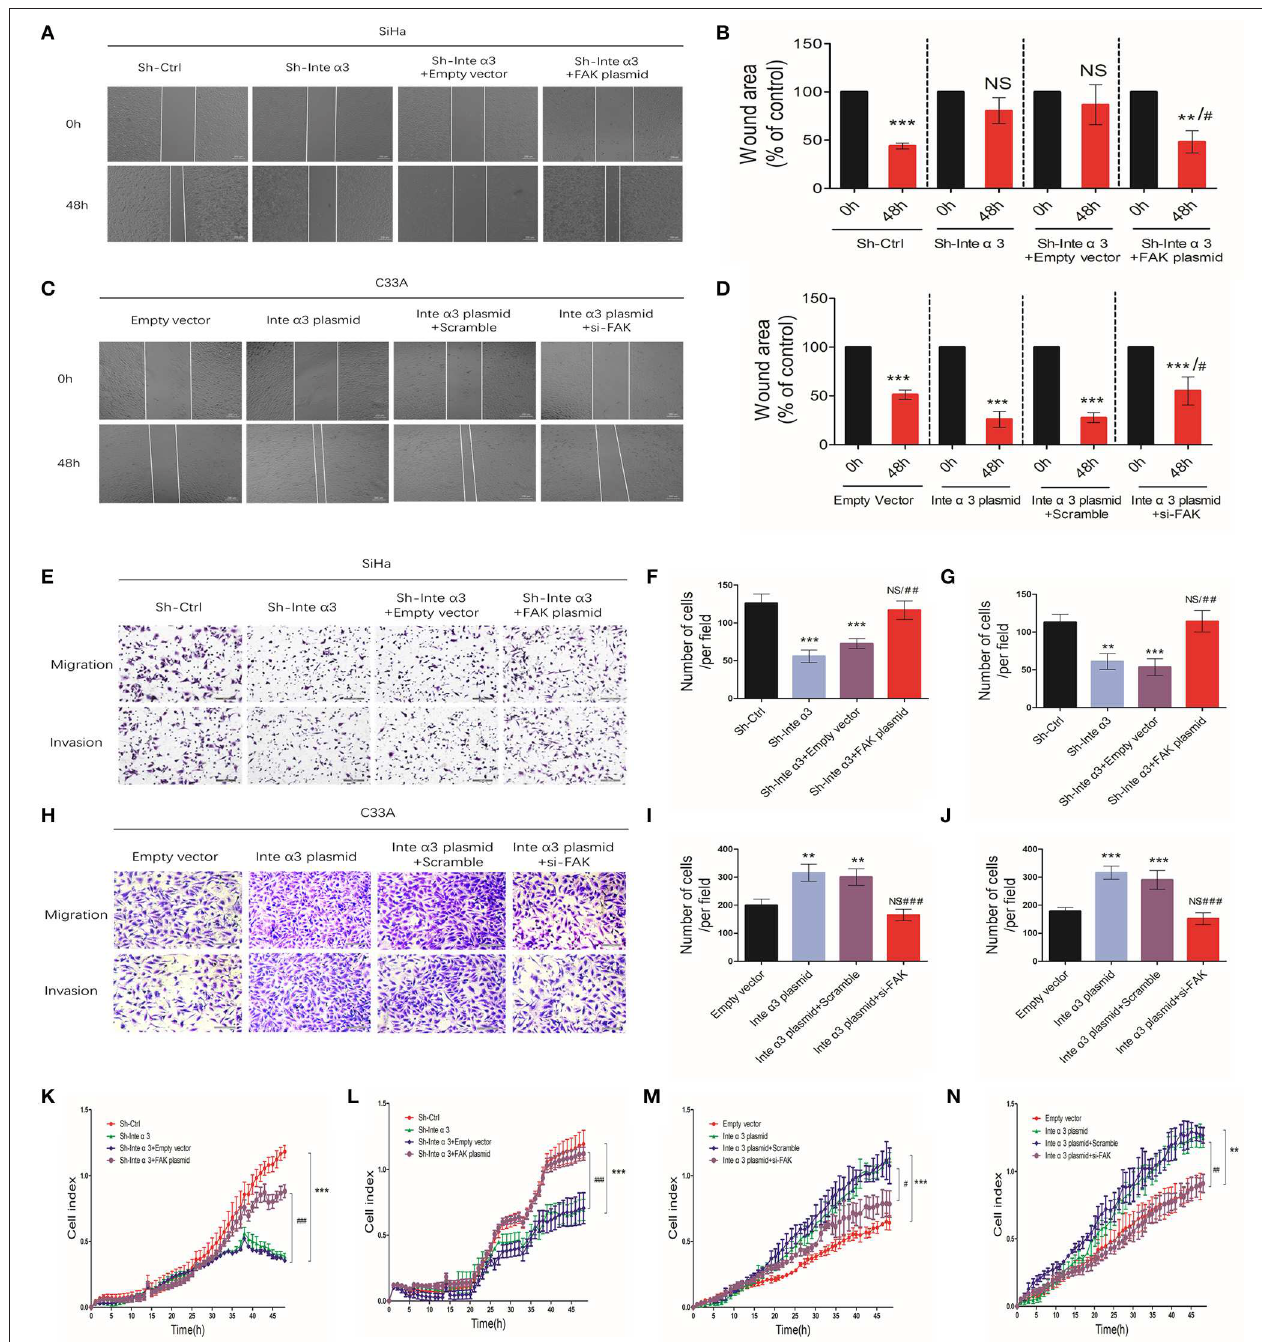
FIGURE 5 | Integrin α 3 promotes the migration and invasion of cells via focal adhesion kinase (FAK). (A) The wound healing assay was applied in SiHa cell to explore the migration of cervical cancer cells in the four groups—Sh-Ctrl, Sh-Inte α 3, Sh-Inte α + empty vector, and Sh-Inte α 3 + FAK plasmid—and the quantification is presented in (B) . (C) The wound healing assay was applied in C33A cell in the four groups—empty vector, Inte α 3 plasmid, Inte α 3 plasmid + Scramble, and Inte α 3 plasmid + si-FAK—and the quantification is presented in (D) . (E) Transwell migration and invasion assays in SiHa cells were performed in the four groups in (A) , and corresponding quantification of migration and invasion cells is shown in (F,G) . (H) Transwell migration and invasion assays in C33A cells were performed in the four groups in (C) , and corresponding quantification of migration and invasion cells is shown in (I,J) . (K,L) Results related to cell migration and invasion using real-time migration/invasion monitoring in SiHa cell in the aforementioned groups in (A) . (M,N) Results related to cell migration and invasion using real-time migration/invasion monitoring in C33A cell in the aforementioned groups in (C) . ** P < 0.01; *** P < 0.001; # P < 0.05 vs. corresponding group (e.g., Sh-Inte α + empty vector vs. Sh-Inte α 3 + FAK plasmid); ## P < 0.01; ### P < 0.01.